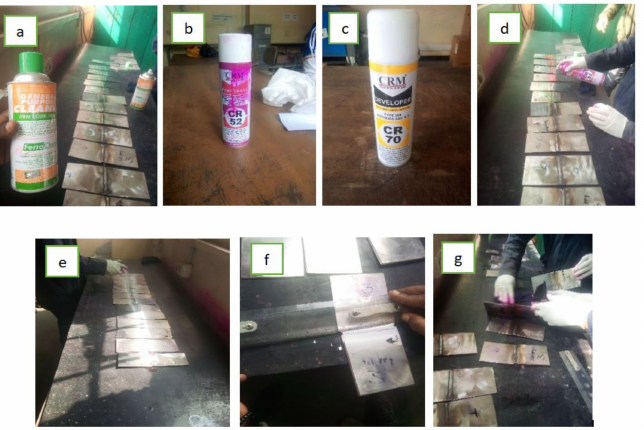
Figure 7. PT processes: ( a ) precleaning samples by using general purpose cleaner; ( b ) penetrant for segregation; ( c ) developer; ( d ) application of a penetrant liquid; ( e ) application of developer; ( f ) inspection of test surface; ( g ) post-inspection cleaning (anticorrosion solutions).